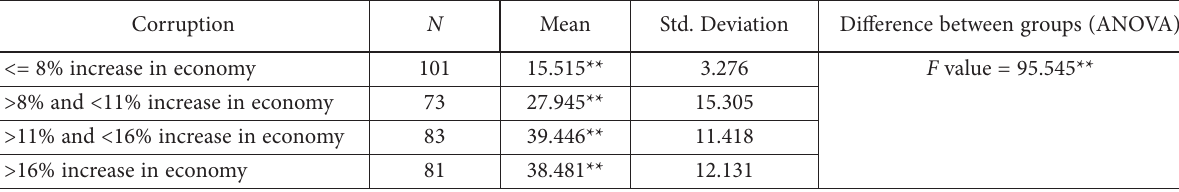
Table 5. Association between increases in corruption and the incidence of under invoicing (source: author’s calculation) Corruption N Mean Std. Deviation Difference between groups (ANOVA) 101 F value = 95.545**